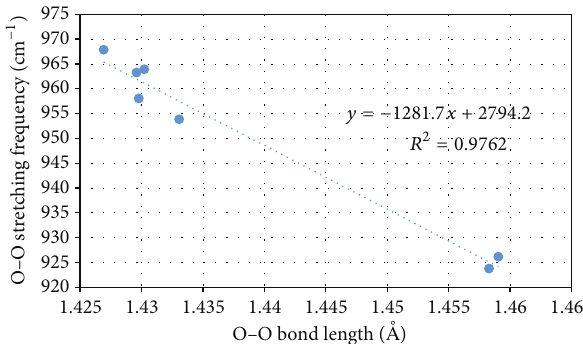
Figure 4: Plot of O–O stretching frequencies against O–O bond length for complexes reported in this